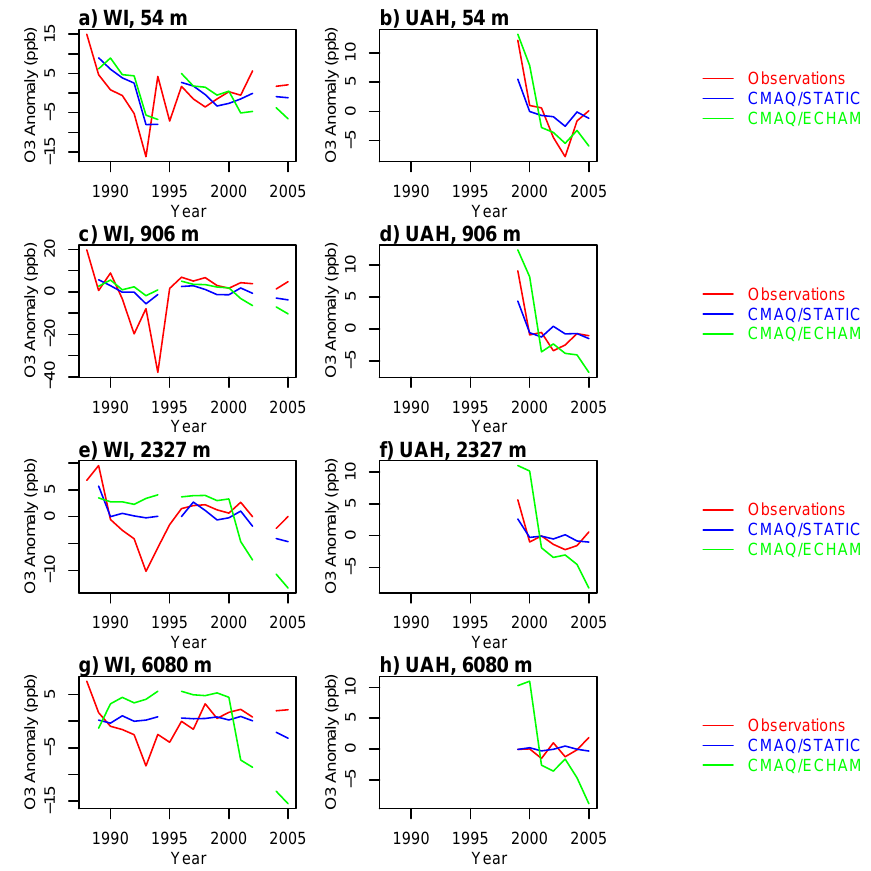
Fig. 14. Time series of observed and simulated annual average ozone anomalies at different heights for Wallops Island (left) and Huntsville (right). The annual mean anomalies were calculated by subtracting the overall mean concentration for a given dataset from the annual mean concentrations that were calculated for all available observations and corresponding model predictions in a given